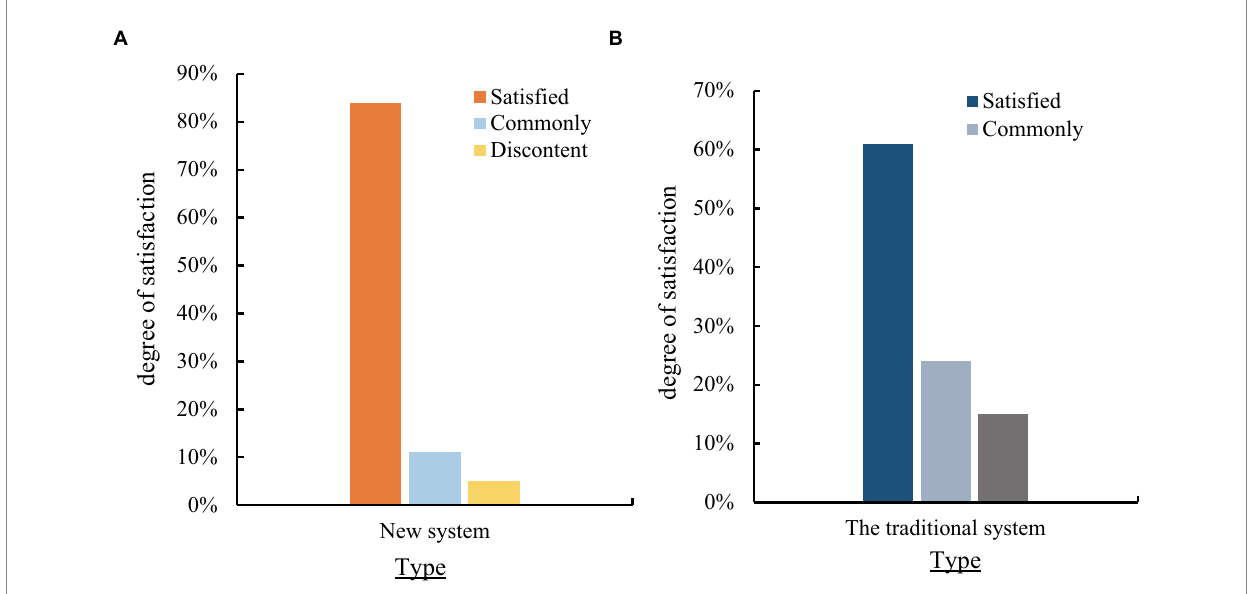
FIGURE 7 Comparison of residents’ satisfaction with the public health information system of the traditional and new community health records grassroots management system. (A) Satisfaction of the public health information system of the new community health records grassroots management system. (B) Satisfaction of the public health information system of the traditional community health records grassroots management